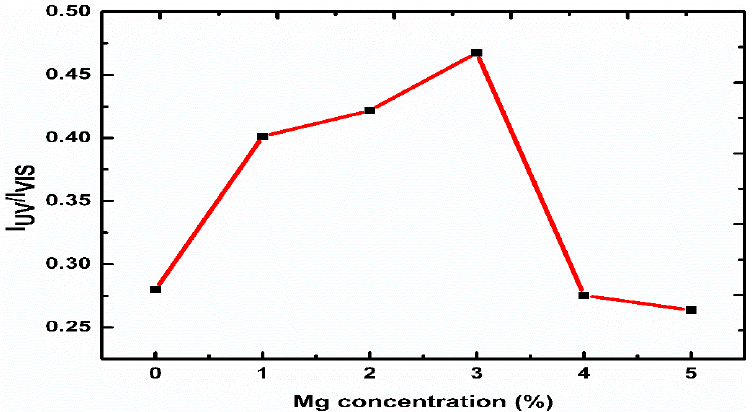
Figure 4. The intensity ratio I UV /I VIS of the Mg-doped ZnO nanorods with different Mg concentra- tions.